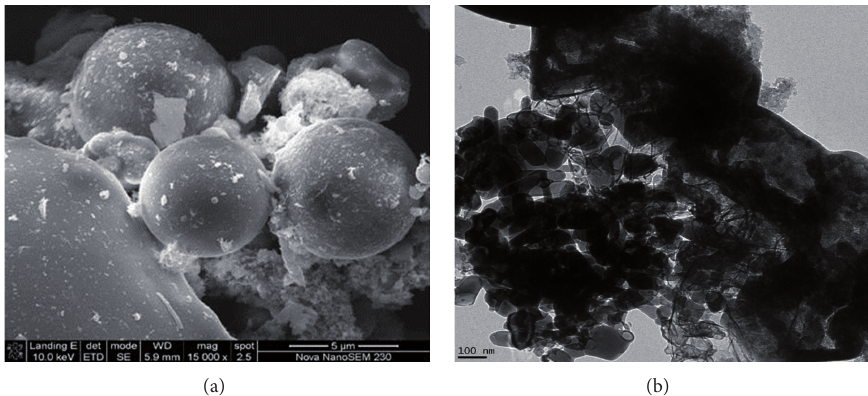
F 9: (a) ��� of activated carbon-�y ash-n�nO composite material. (b) ��� of activated carbon-�y ash-n�nO composite material.